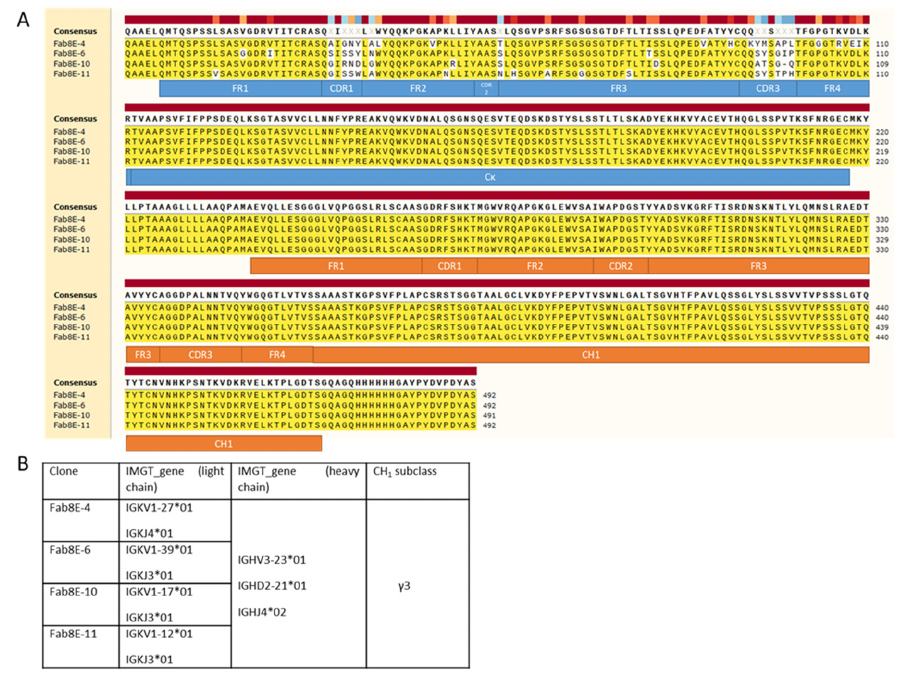
Figure 3. Sequencing results, chain families and features identification of the gliadin-binding selected clones. ( A ) Alignment of the sequences coding for the Fab8E-4, 6, 10 and 11. Main antibody features are shown in blue and orange charts for light and heavy chains, respectively. Alignment was computed using SnapGene ® 5.0.8. ( B ) Identification of the re-arranged genes coding the light and heavy chains of the isolated gliadin-binding clones. The VJ and VDJ genes were elucidated using the IMGT ® /V-QUEST tool, and the IgBLAST tool from NCBI was used for elucidating the CH1 subclass of the heavy chains.